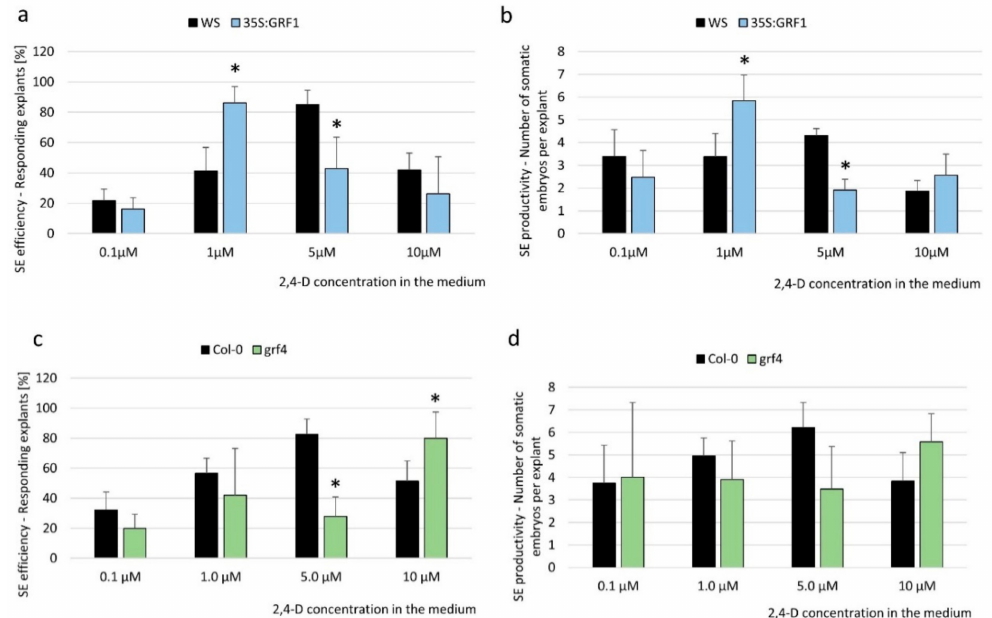
Figure 5. GRF1 and GRF4 controlled the embryogenic response of the explants that had been cultured on the auxin media. Explants of ( a , b ) the 35S: GRF1 line, ( c , d ) the grf4 mutant, and their WT genotypes, (Wassilewskija (WS) and Col-0, relevantly) were cultured on an SE induction medium that had been supplemented with di ff erent concentrations of 2,4-D. ( a , c ) The e ffi ciency and ( b , d ) productivity of SE were evaluated in a 21-day-old culture. Values that were significantly di ff erent from those of the WT culture are indicated with asterisks (*) p < 0.05; n = 3 ±